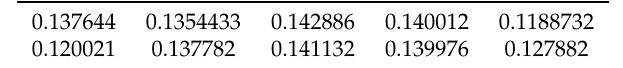
Table 3. Testing results of the neural network applied to the testing